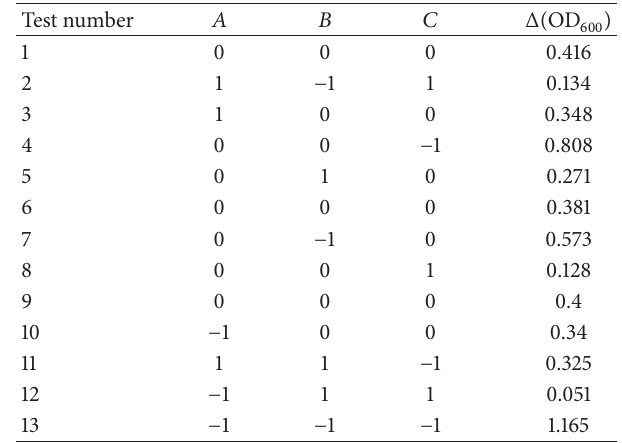
Table 3: Design matrix and corresponding observed Δ (OD 600 ).